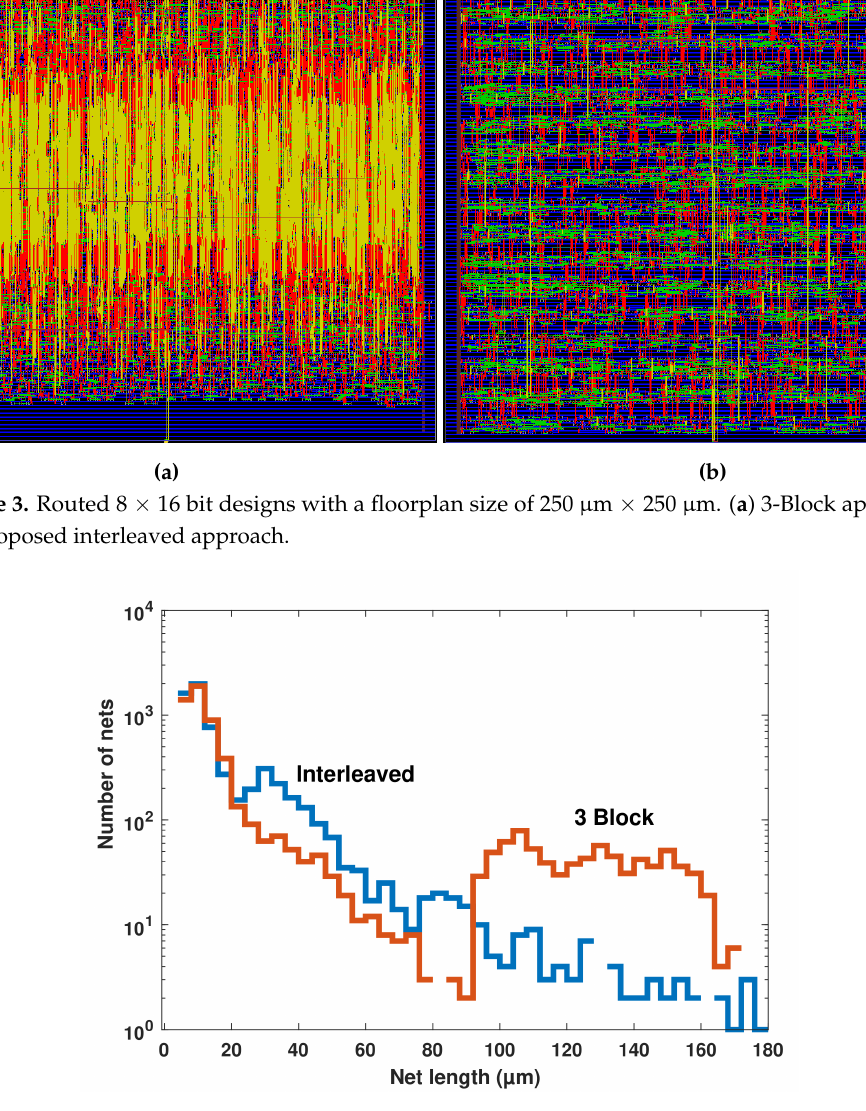
Figure 4. Net length histogram for the 8 × 16 bit